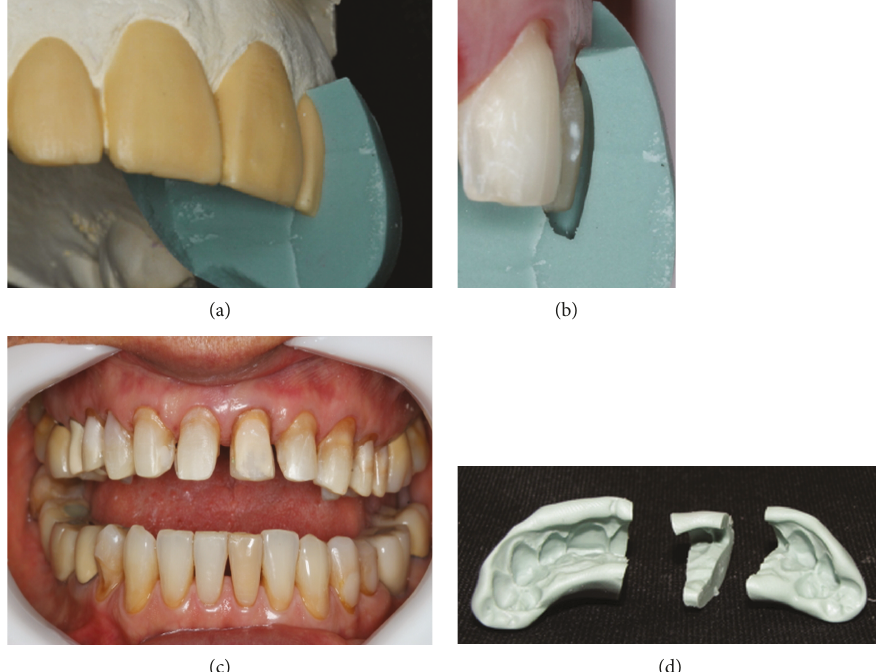
Figure 4: (a) Silicone guide on the wax-up model. (b) Silicone guide cut along the long axis of the tooth. (c) Preparation using the guide. (d) Preparation fi nalized.